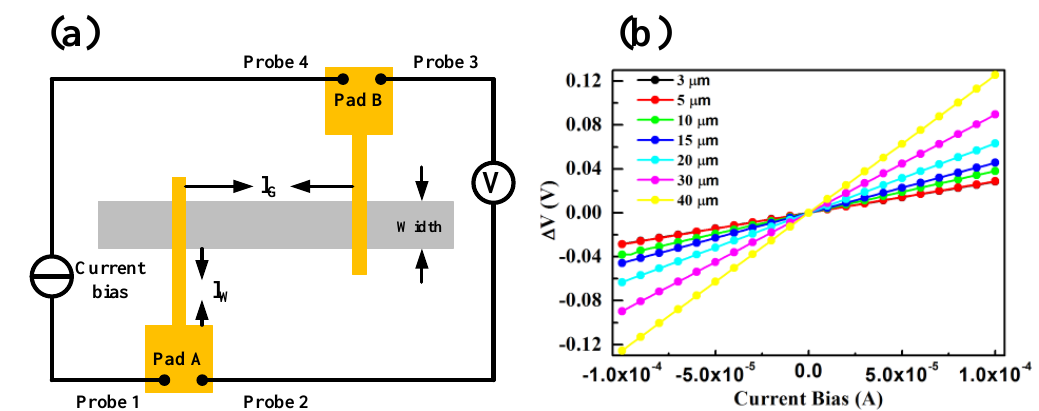
Figure 3. ( a ) Four probe configurations and ( b ) measured current-potential drop characteristics of typical G-M contact with different l G in TLM test structures.